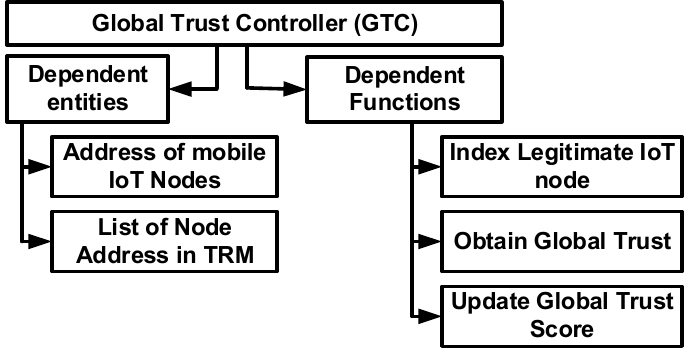
( b ) Figure 2. Format of newly formulated control message: ( a ) format for C msg1 ; ( b ) format for C msg2 . 5.2. Public Cloud IoT System This work employs game theory to deploy its security scheme based on global trust and the selection of CIN. To accomplish this, a simplified dual controller design, namely GTC and CSC, is used in the development of an agreement system. The following is an